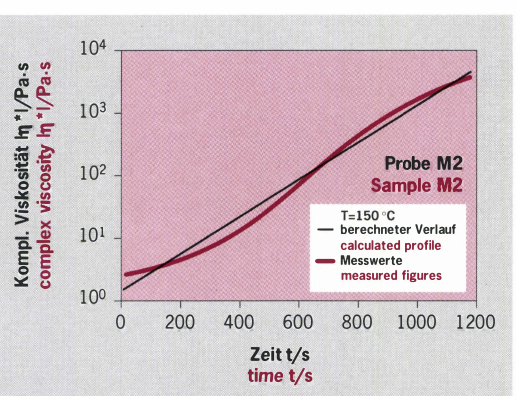
Fig.9: Measured and calcu­ lated viscosity profile for the filled epoxy resin M